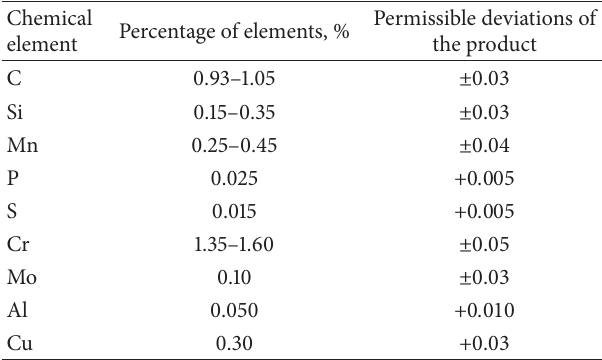
Figure 1: SEM micrograph of the grinding debris from AISI 1055 steel showing a hollow spherical particle with a fine dendritic microstructure both outside and inside the sphere [11].